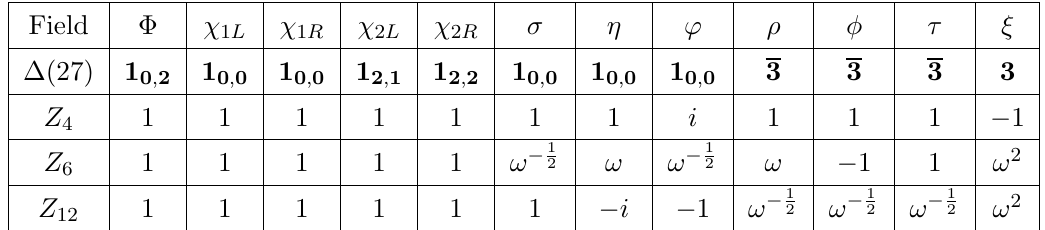
Z 4 Z 6 Z 12 . (cid:10) (cid:10) (cid:10)